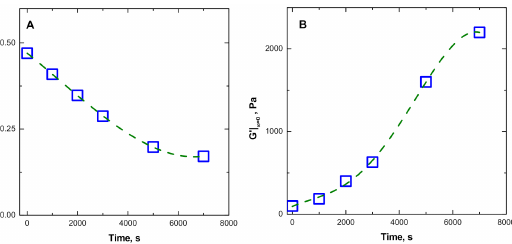
Figure 8. ( A ) Gradient ( m ) of the G’ curves in the terminal region and ( B ) static modulus ( G ’| ω = 0) for the for the ENR + SiO 2 melt.